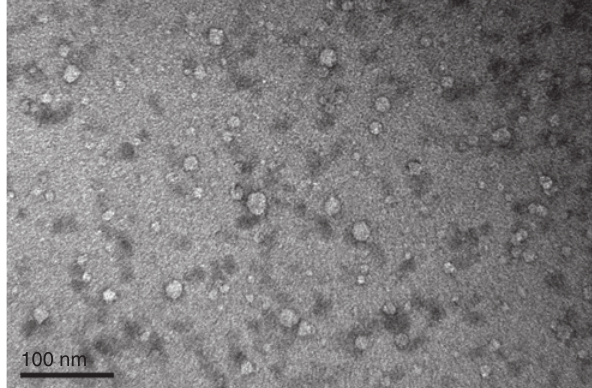
Figure 5: TEM micrograph of SPUA8 emulsion particles.